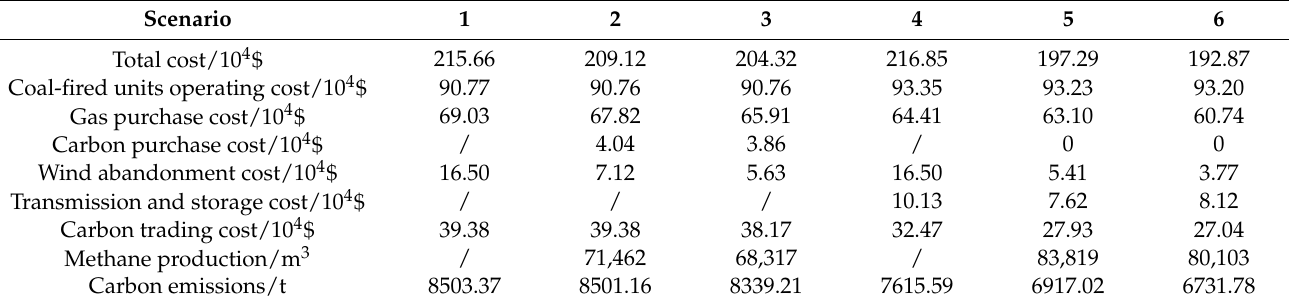
Table 3. Low-carbon economics dispatch results of di ff erent scenarios.